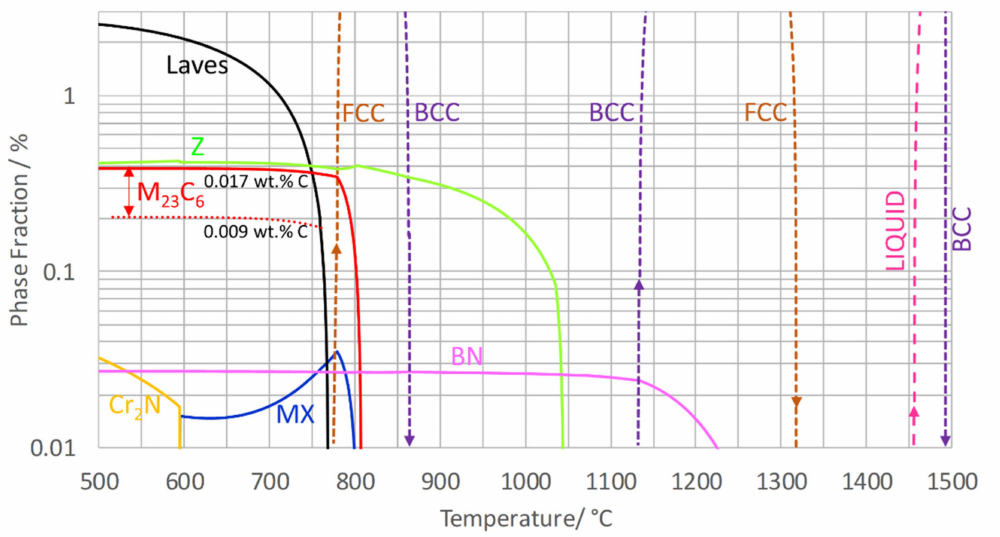
Figure 7. Calculated molar equilibrium phase fractions in